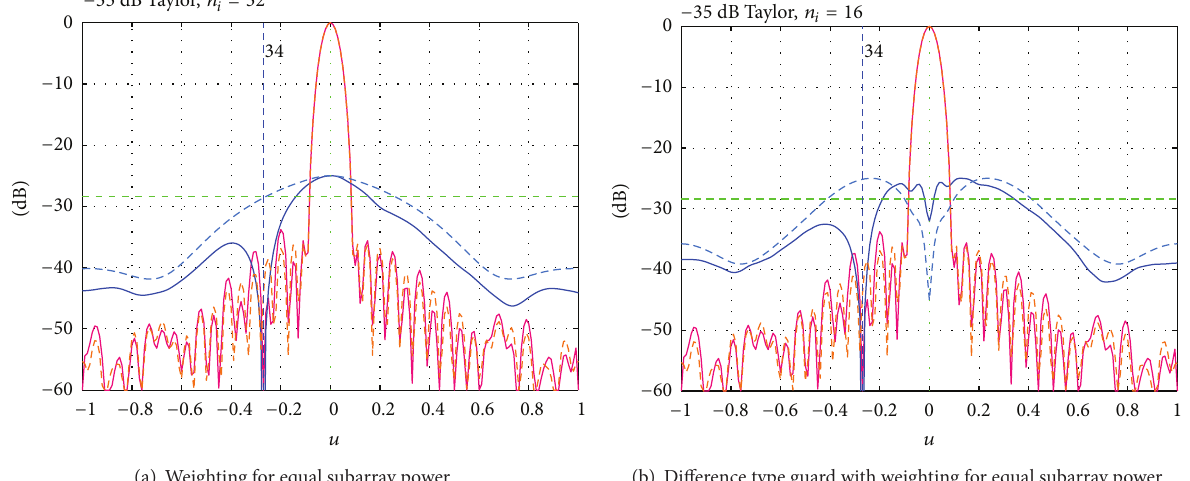
Figure 16: Adapted guard patterns for jammer at 𝑢 = − 0.27 ( − 15.7 ∘ ) with JNR of 34 dB for generic array.